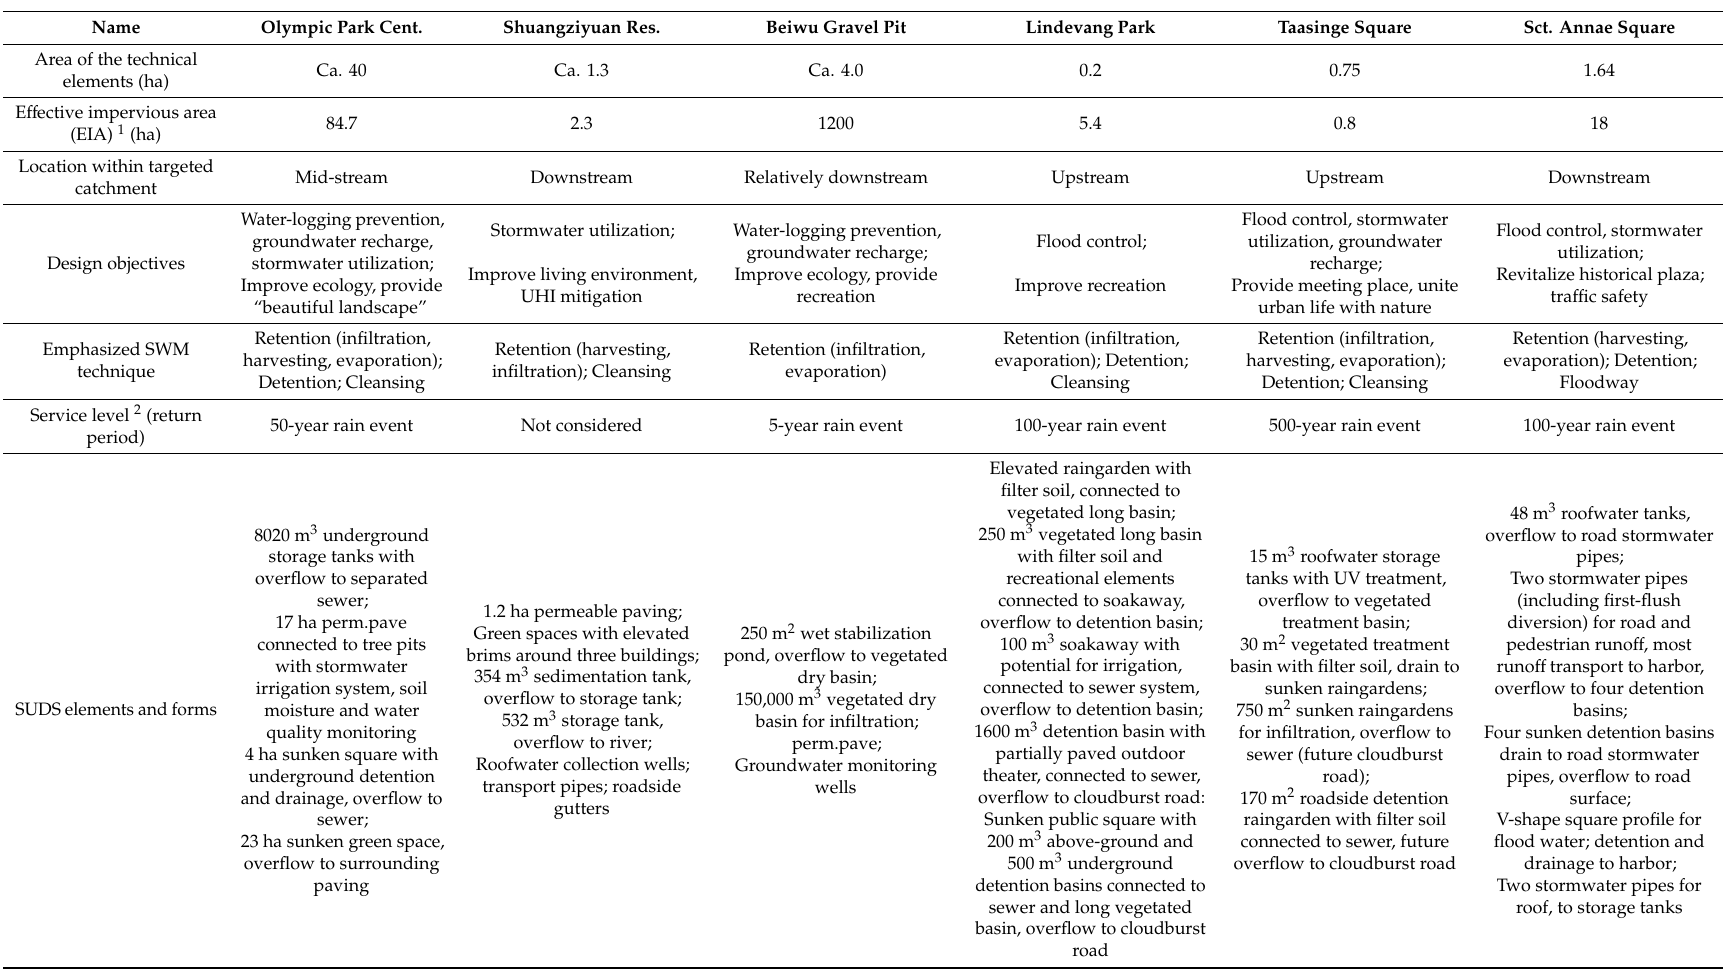
Table3. Overviewofthesixmunicipal-ledstormwatermanagementpilotprojectsinBeijingandCopenhagen. SWM = stormwatermanagement, perm.pave. = permeable pavement, BWSTI = Beijing Water Science and Technology Institute, TMF = Technical and Environment Administration, Municipality of Copenhagen, HOFOR = Greater Copenhagen